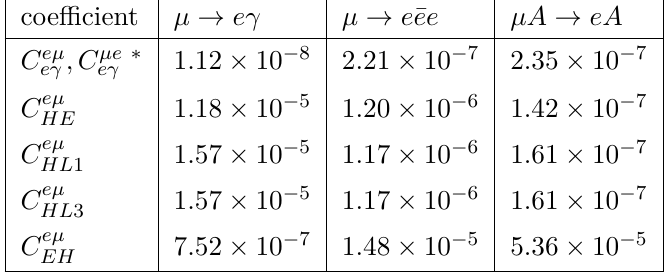
Table 5 . Current sensitivities of the processes in the first row to the coefficients of SMEFT operators at m W , added to the Lagrangian as in eq. (A.1). C eµ